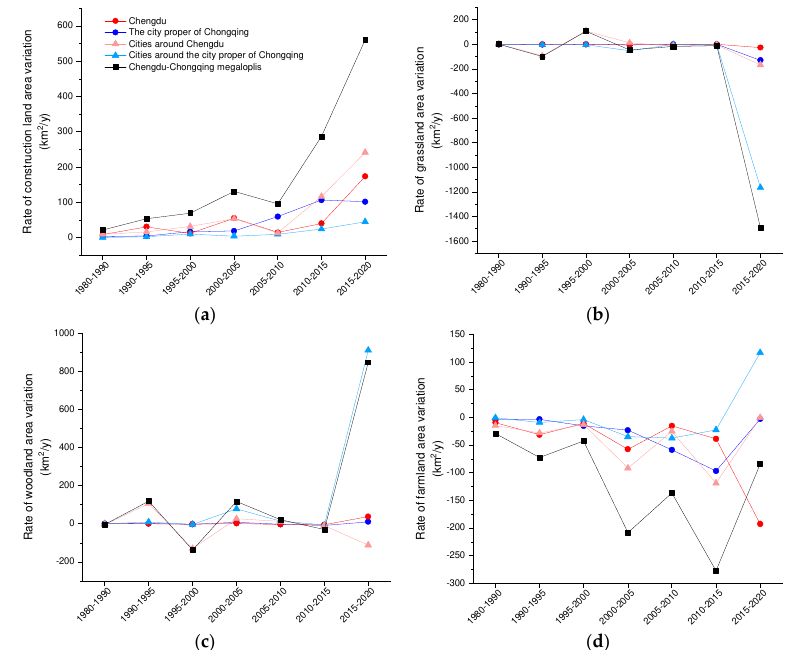
Figure 5. Area variation rate of different land-use types in the Chengdu-Chongqing Megalopolis. ( a ) Construction land area variation rate; ( b ) grassland area variation rate; ( c ) woodland area variation rate; ( d ) farmland area variation rate.